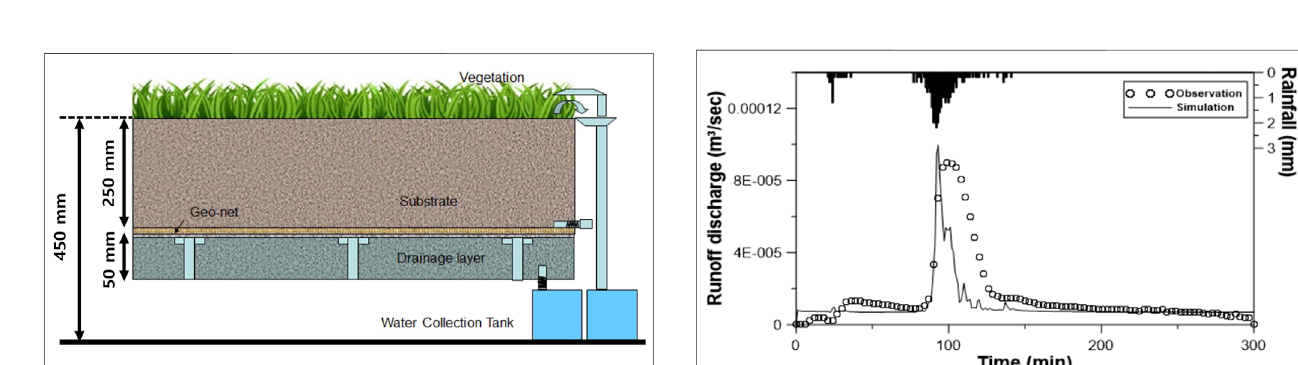
FIGURE 1 | Green roof test bed at NTU in Singapore: (A) overall layout; (B) design concept of a main frame.